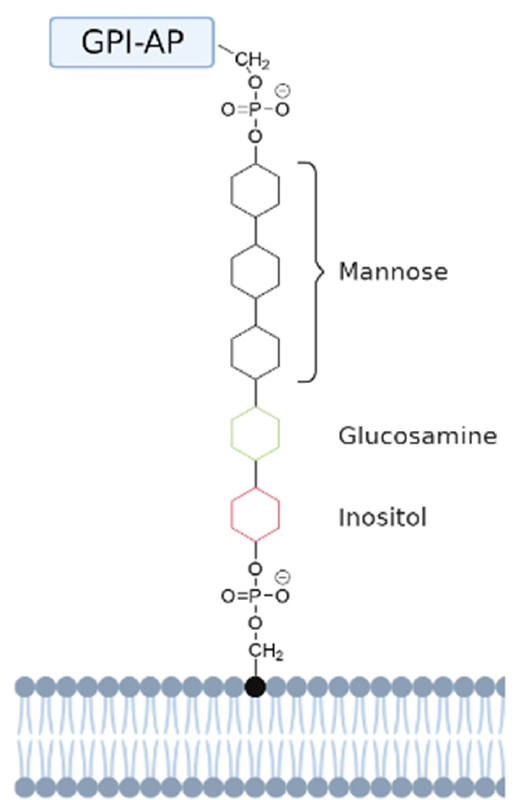
Figure 4. Schematic representation of a GPI-anchored protein. The GPI-anchored protein (GPI-AP) is anchored to the head group of a phosphatidylinositol (PI) lipid via a GPI anchor. This anchor has a conserved core domain consisting of ethanolamine-PO 4 -6Man α 1-2Man α 1-6Man α 1-4GlcN α 1-6 myo -inositol-1-PO 4 -lipid [64]. The mannose, glucosamine, and inositol groups are represented by black, green, and red aromatic rings, respectively.